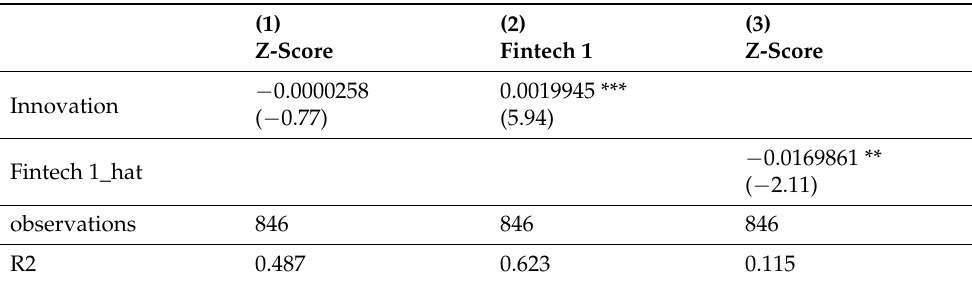
Table 5. Regression results of two-stage least square method